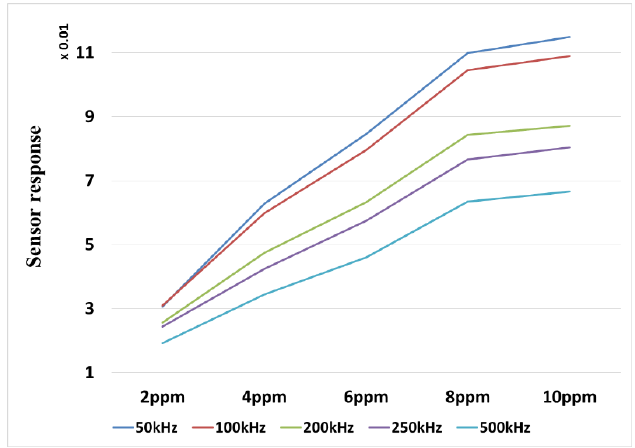
Figure 13. Response of the fractal sensor to NO gases at different frequencies.